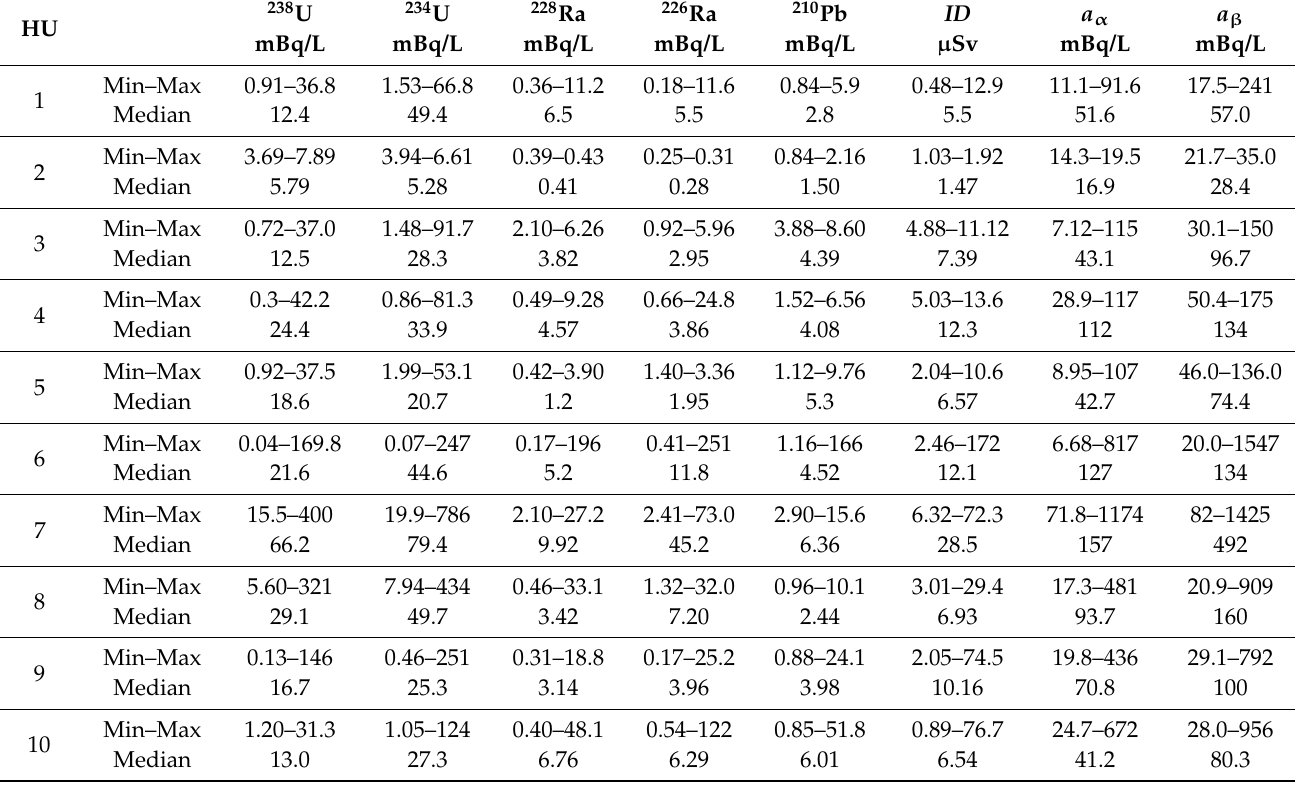
Table 3. Minimum, maximum and median radioactivity values of the analysed samples according to their respective hydrogeological unit (HU). Results from HU nº 14 are not included because samples were not gathered from